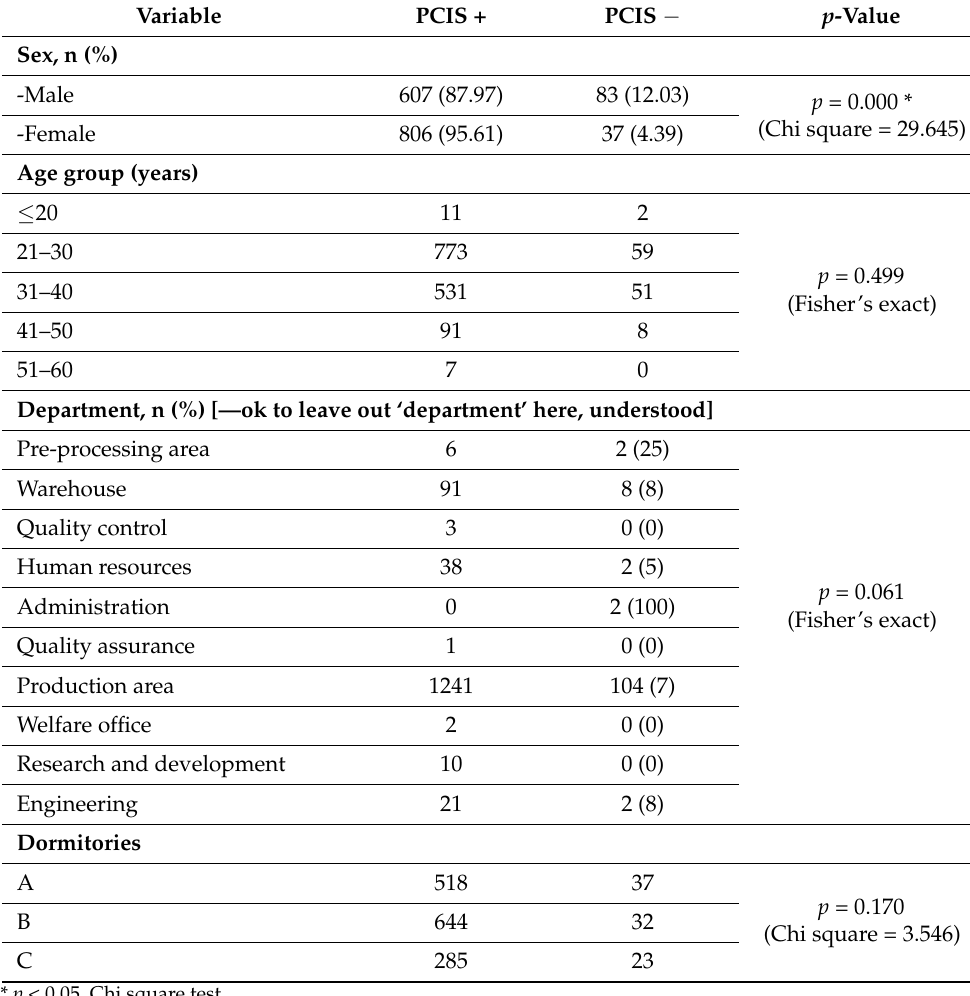
Table 1. Study variables which were associated with positive post-COVID-19 infection status (PCIS) (positive RT-PCT for COVID-19 or COVID-19 antibody test) (n = 1533, 6 cases